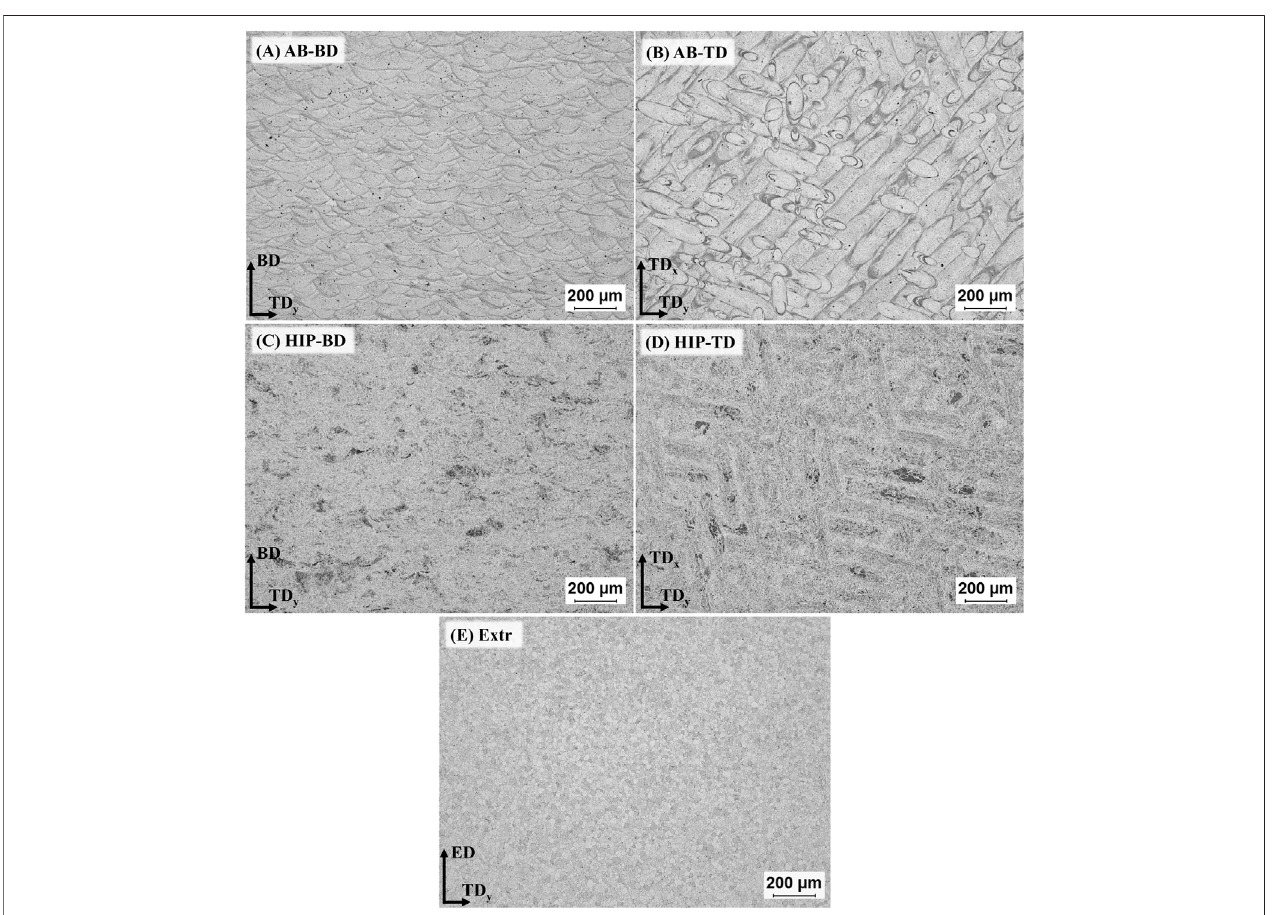
FIGURE 2 | LOM images of the samples after 5s etching in 2% Nital, for (A) AB-BD direction, (B) AB-TD direction, (C) HIP-BD direction, (D) HIP-TD and (E) Extr material.